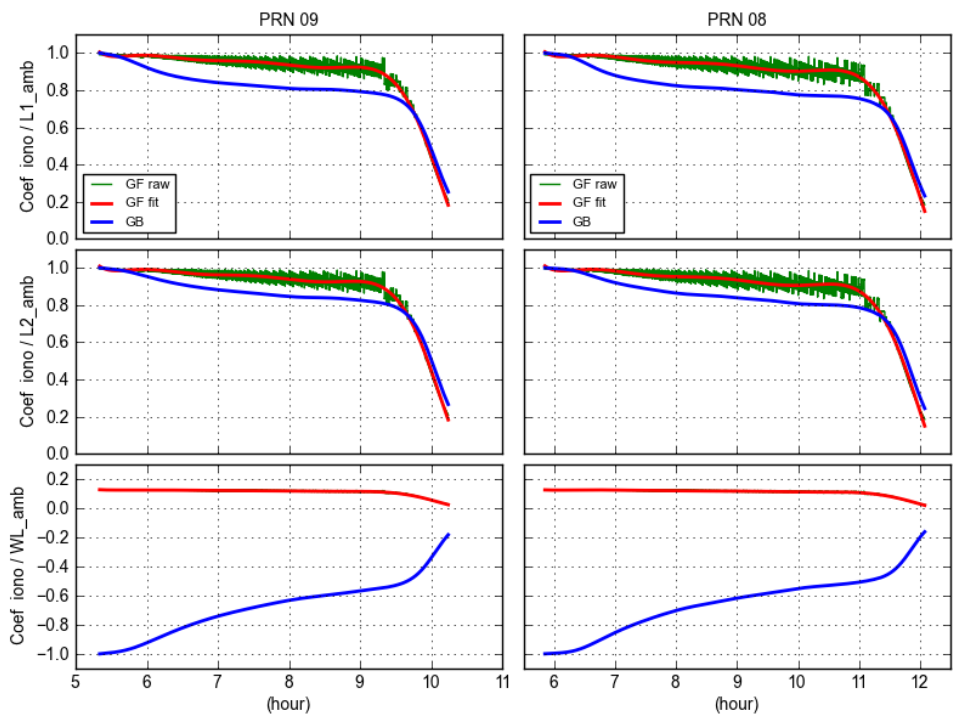
Figure 10. Correlation coefficients between ionospheric delay and L1 ambiguity estimates ( top ), and L2 ambiguity estimates ( middle ), and WL ambiguity ( bottom ) for PRN 08 ( right ) and PRN 09 ( left ) at site GODZ. The derived GF raw coefficients are shown in green, the fitted line of the GF raw coefficients are shown in red, while the GB coefficients are indicated in blue. The least-square polynomial with a degree of 8 is used to fit the GF raw coefficients. The green lines of WL in the bottom panel are overwritten by the red curve.